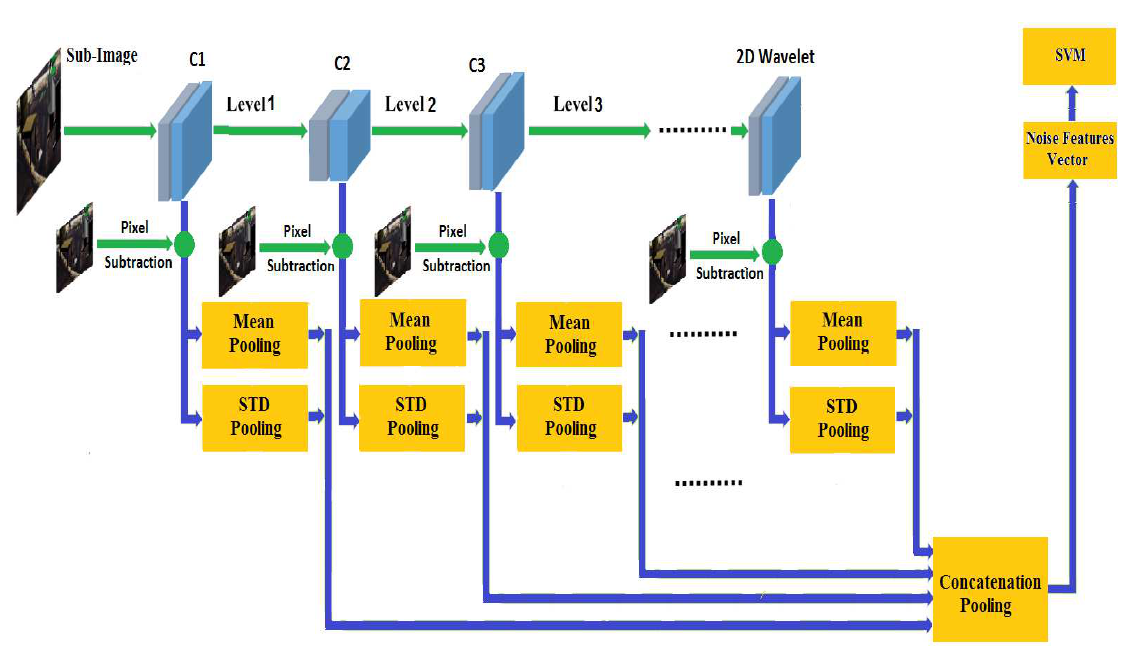
Figure 5. Architecture of the convolution neural network.